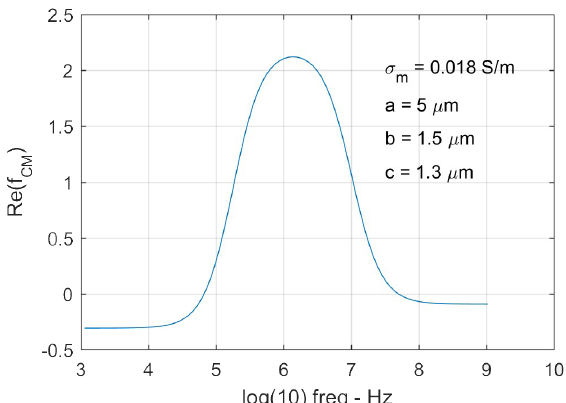
Figure 3. A representative Clausius-Mossotti (CM) factor of a deformed RBC based on the triaxial ellipsoid multi-shell model. The semi-principal axes of the cell are a = 5 µm, b = 1.5 µm, and c = 1.3 µm.